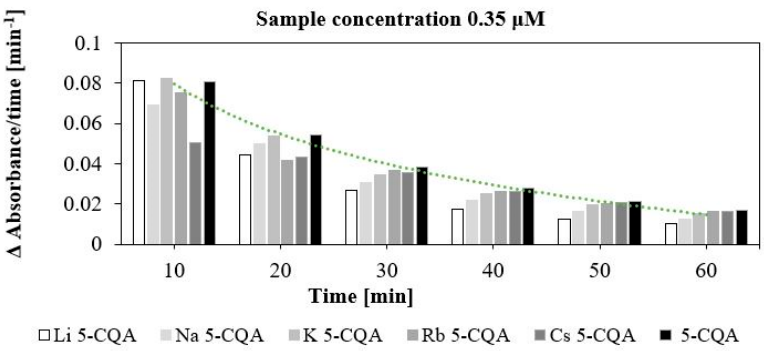
Figure 5. Comparison of the effect of the studied compounds at the concentration 0.25 and 0.35 µ M on the oxidation rate of trolox.